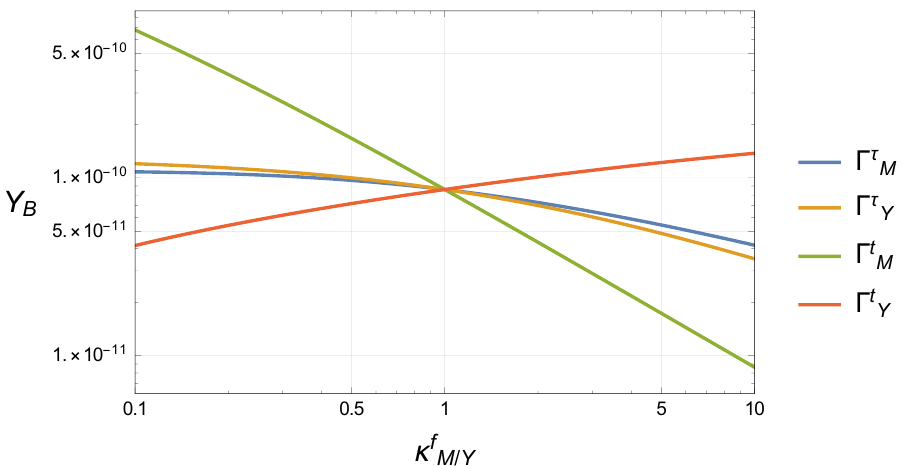
Figure 1. Y B as a function of the modifier κ f the τ and t